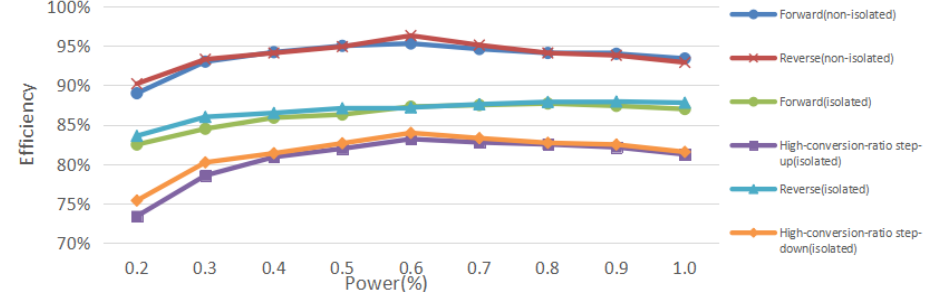
Figure 16. Efficiency curves of the proposed converter.